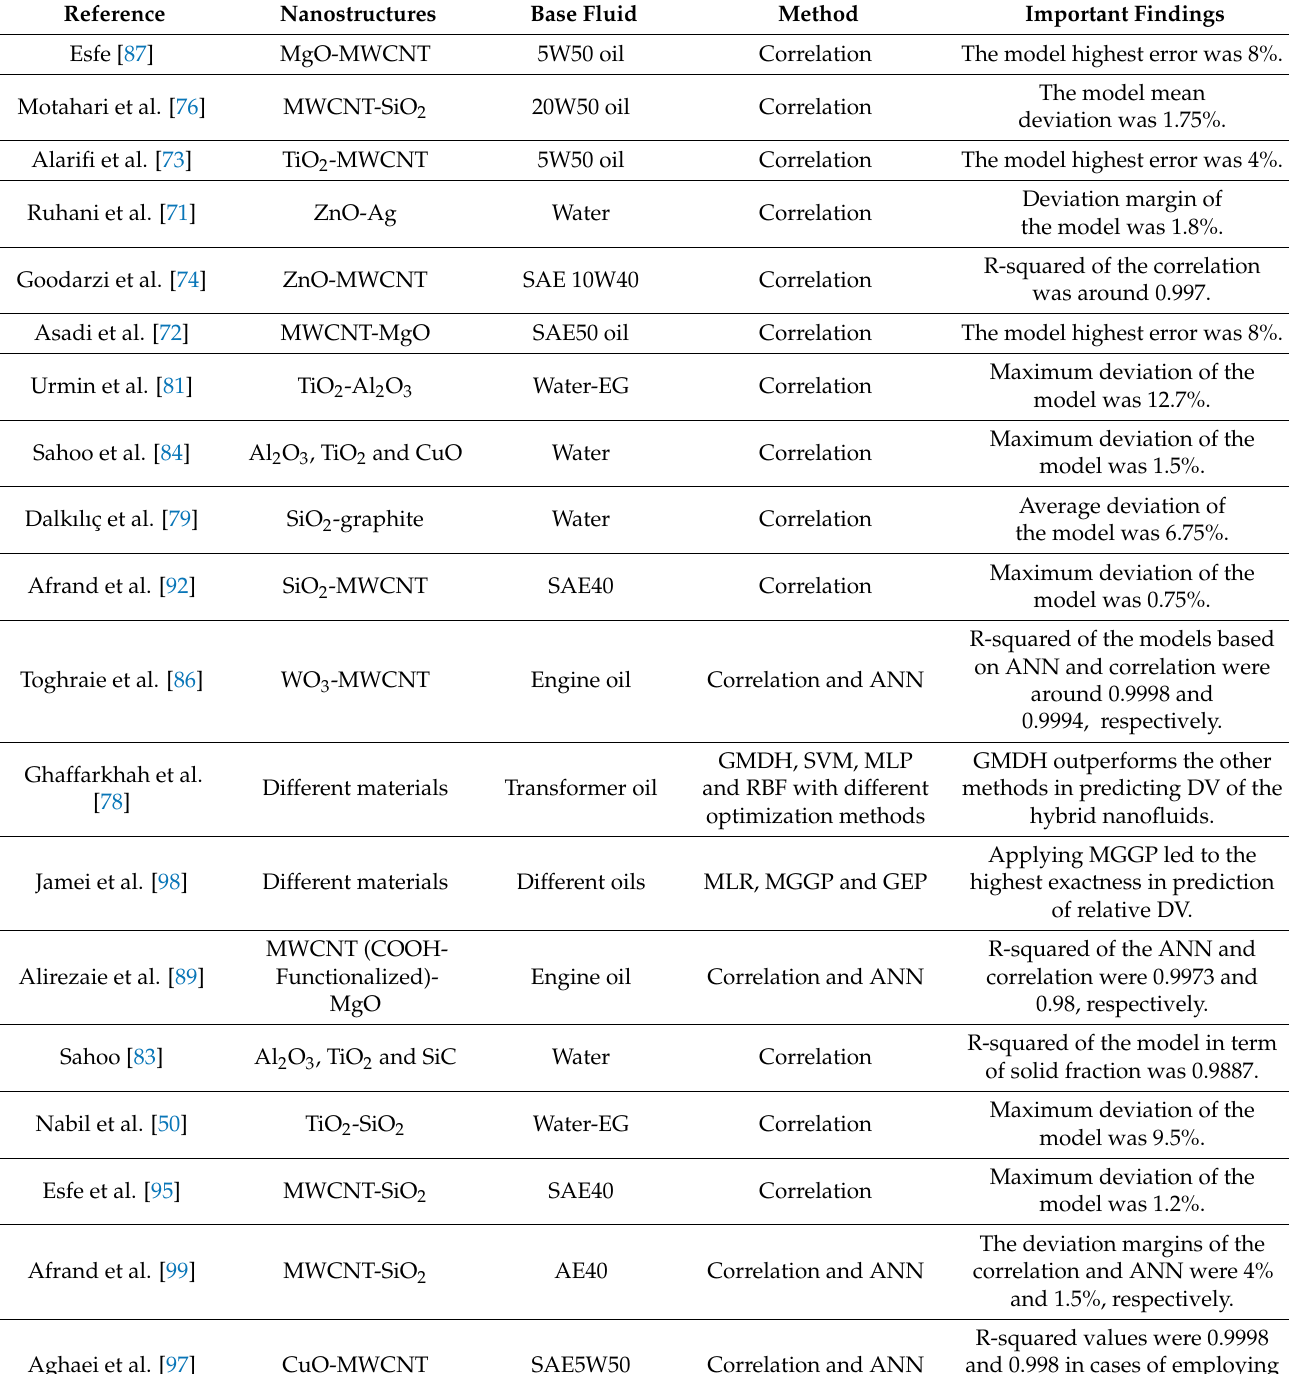
Table 6. Proposed models for the DV of hybrid